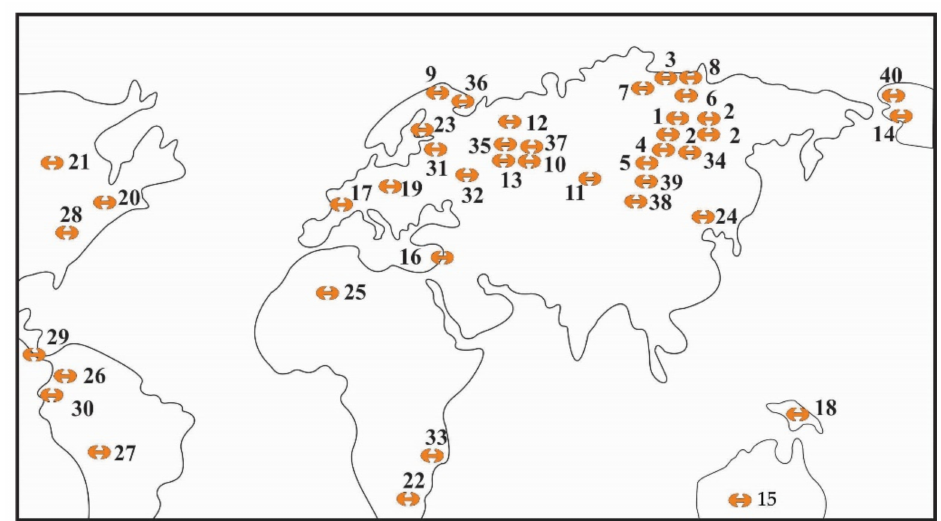
Figure 1. Scheme of distribution of spherical hollow and toroidal gold in different regions of the globe according to researchers: 1 [5]; 2 [2]; 3 [1]; 4 [6]; 5 [7]; 6 [8]; 7 [9]; 8 [10]; 9 [11]; 10 [12]; 11